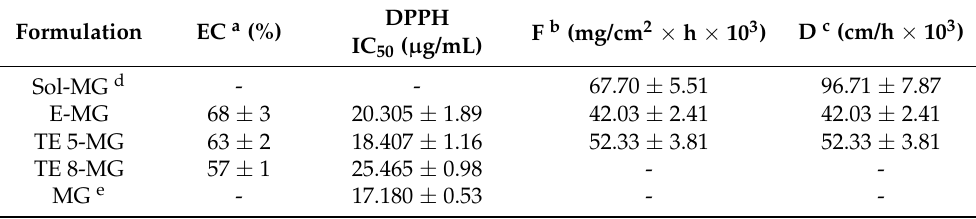
Table 4. Entrapment capacity, DPPH radical-scavenging capacity, and diffusion coefficients of MG-loaded in the indicated formulations.